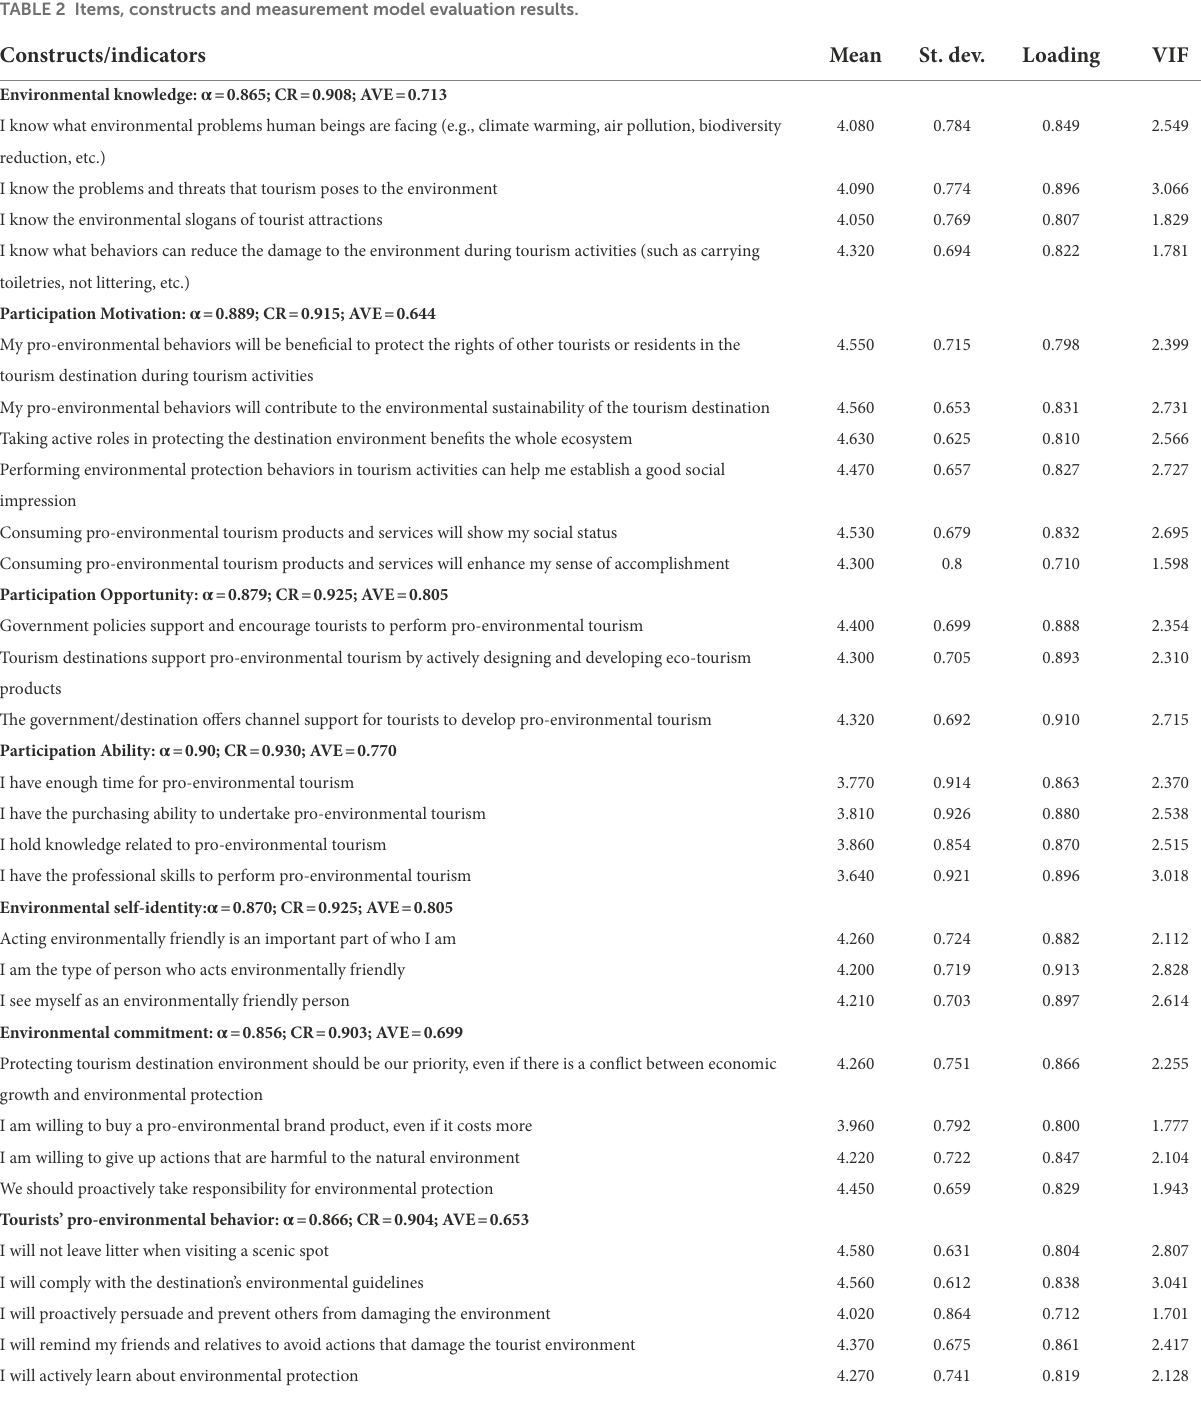
TABLE 2 Items, constructs and measurement model evaluation results. Constructs/indicators Mean St. dev. Loading